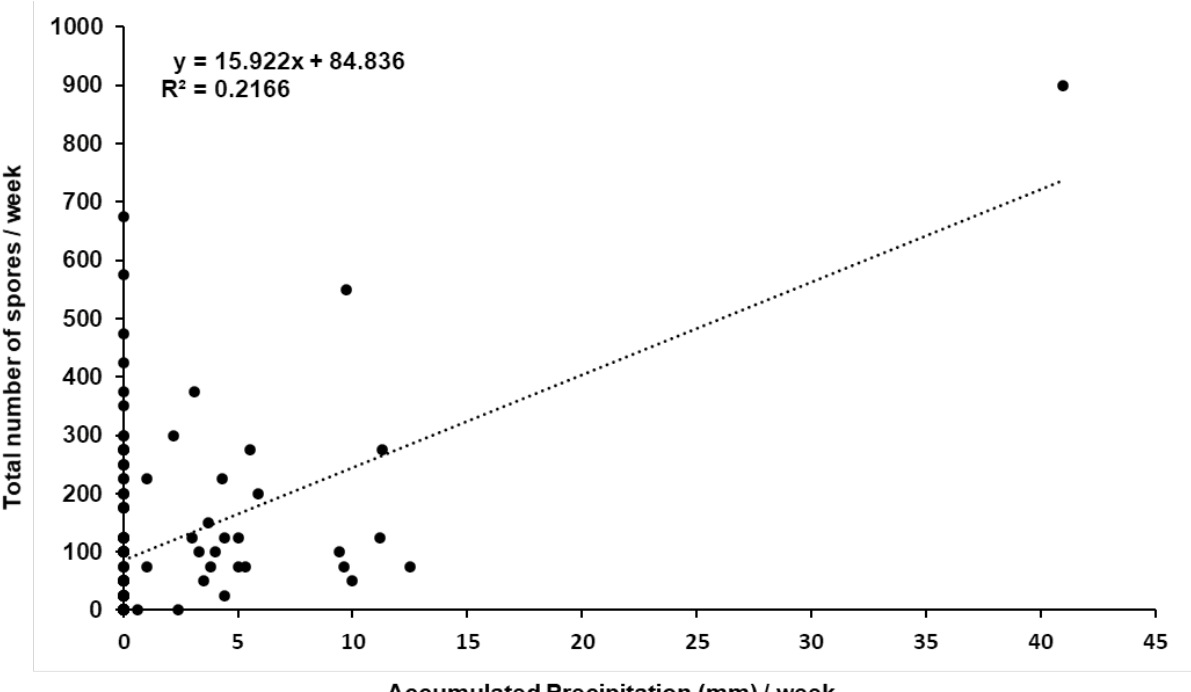
Figure 3. Scatter plot of the relationship between total spores trapped per week using glass microscope slides and precipitation. Linear regression line and equation are also